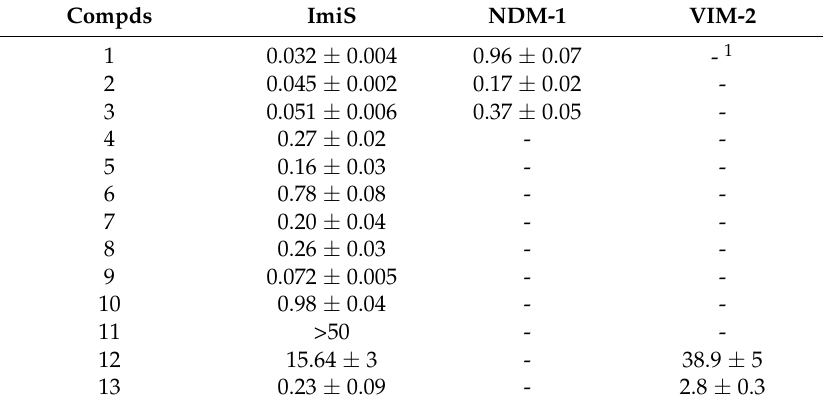
Table 1. IC 50 values of azolylthioacetamides against M β Ls ( µ M).